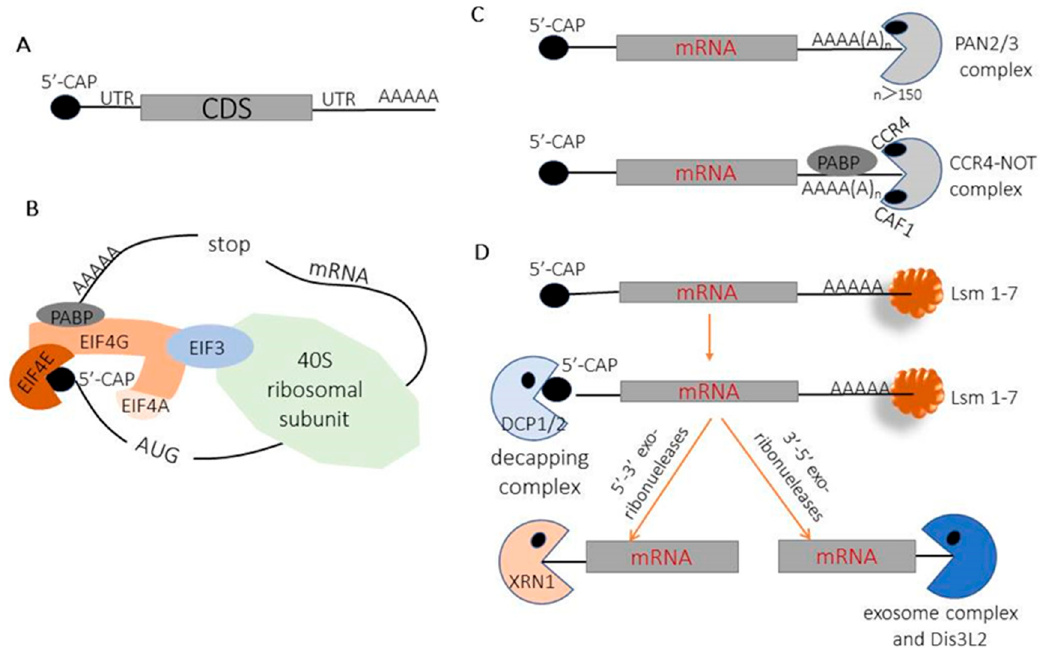
Figure 1. Schematics of cellular mRNA decay pathways. ( A ) Structure diagram of eukaryotic mRNAs; ( B ) conventional cap-dependent translation initiation of eukaryotic mRNA; ( C ) the degradation pathway of removal of the 3 ′ poly(A) tail of mature mRNA; ( D ) the decapping and degradation pathways of the mRNA body.